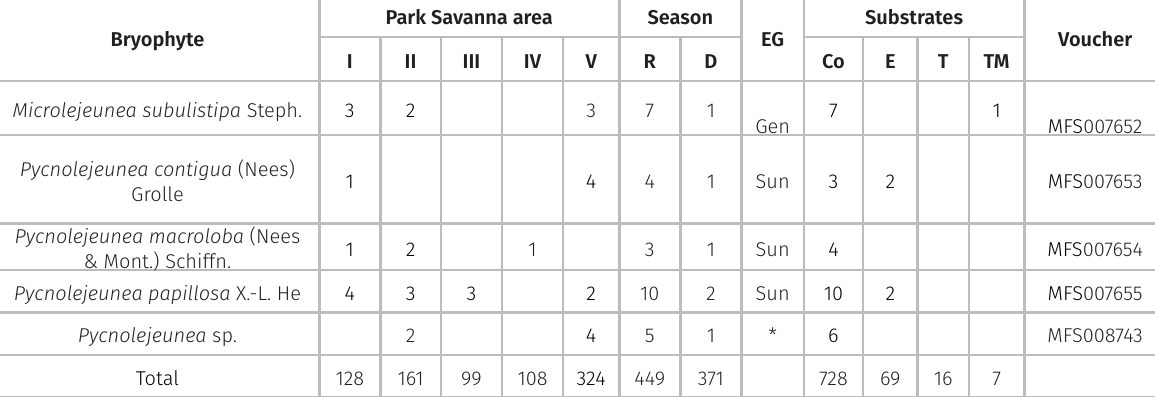
season; D – Dry season; EG - Ecological group; Gen - Generalist; Sun - Sun specialist; *Not determined; Co - Corticolous; E - Epyxilic; T - Terricolous; TM - Termite Mound.